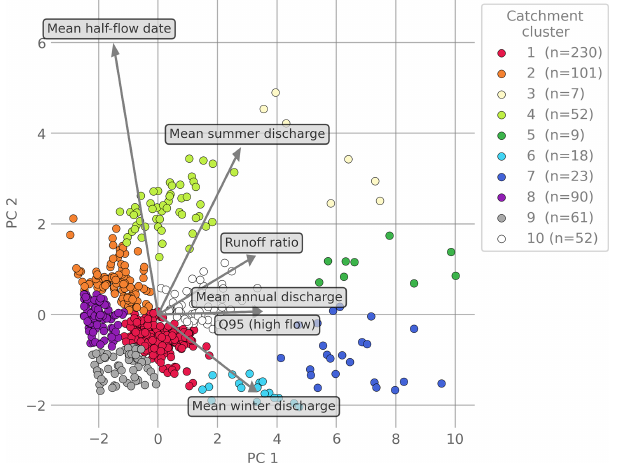
Figure 3. Biplot of the principal components (PCs). Colors indicate the cluster of the catchment. Grey arrows indicate the loadings of the original catchment attributes in the PCA